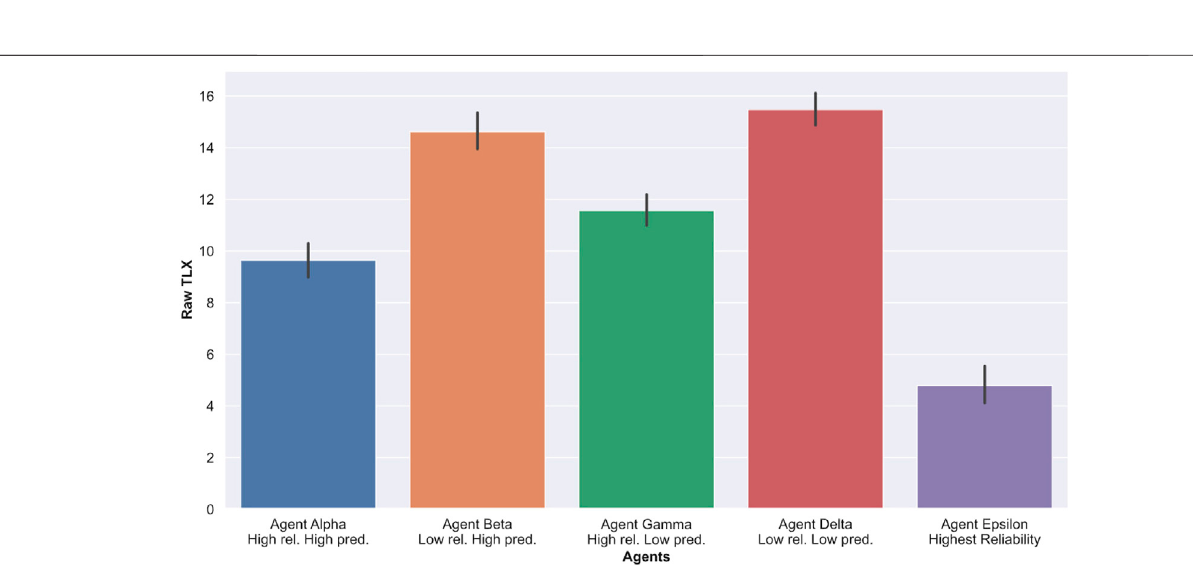
Frontiers in Robotics and AI |